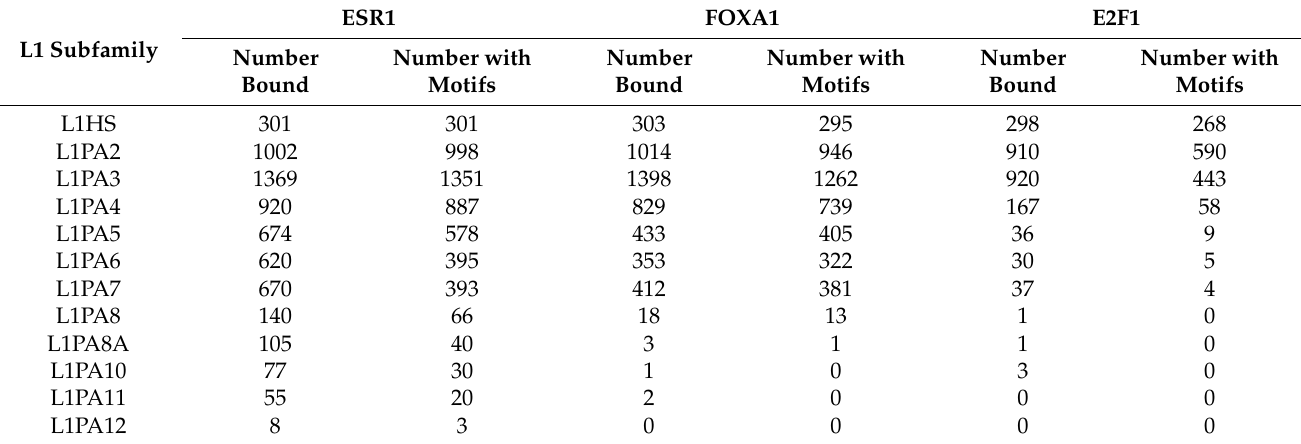
Table 2. The number of L1 5 (cid:48) UTRs containing TFBSs in MCF7 cells and motifs of ESR1, FOXA1 and